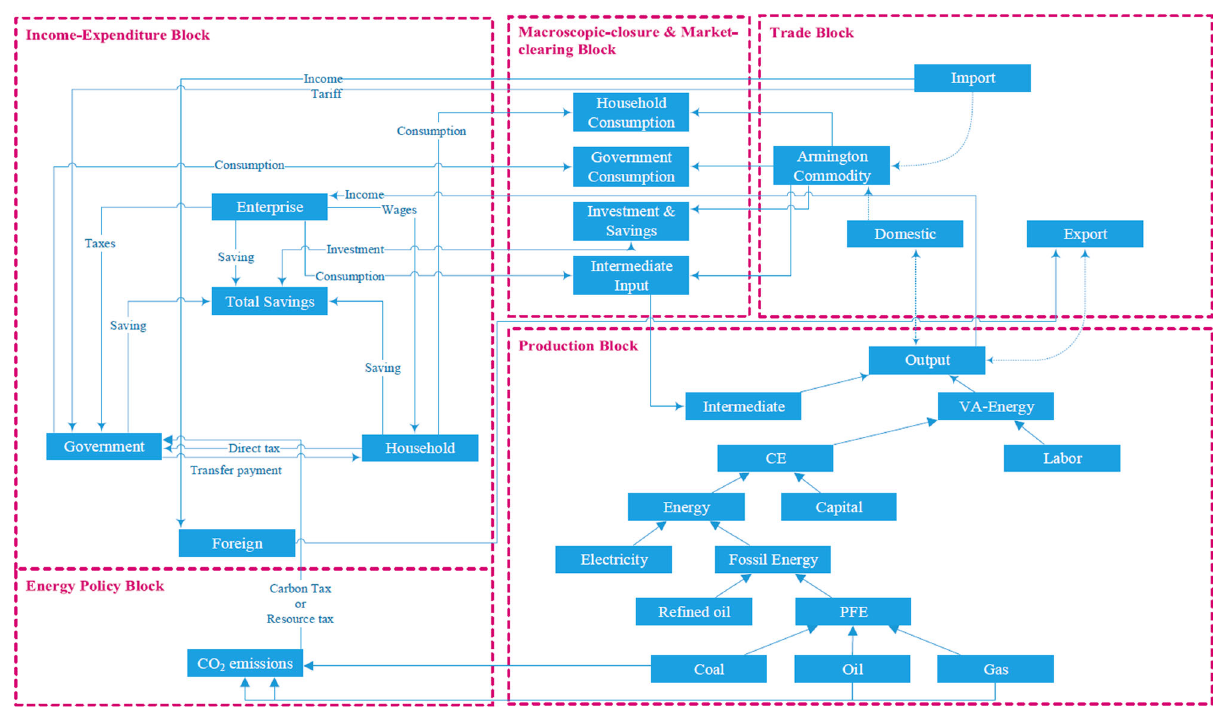
Fig. 1 Framework of CEEEA/CGE model in this paper. The model consists of fi ve blocks: production block, income-expenditure block, trade block, energy policy block, and macroscopic-closure and market-clearing